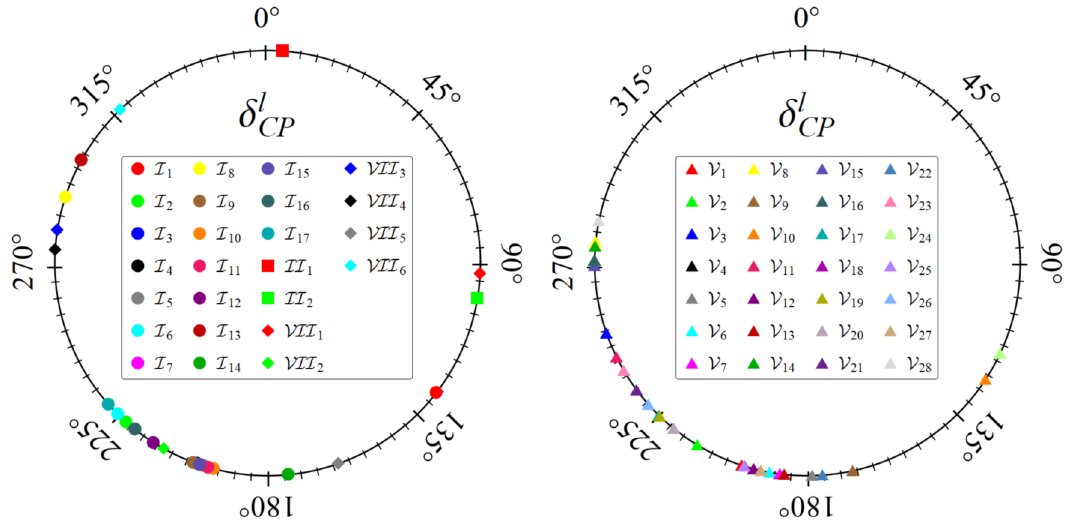
. The left panel is for the models of type-I, CP